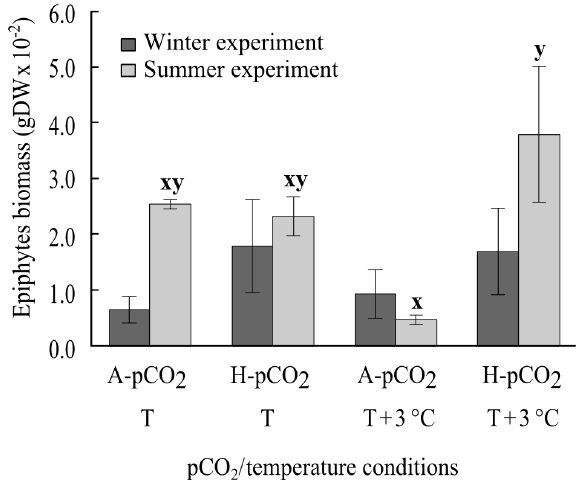
Figure 4. Biomass of epiphytic fleshy algae (mean ± SE, n = 5) ob- tained in the different p CO 2 (A- p CO 2 is ambient p CO 2 ; H- p CO 2 is high- p CO 2 ) and temperature ( T is ambient temperature; T + 3 ◦ C is high temperature) treatments after the 3-month experiments in winter (dark gray) and summer (light gray) experiments. Letters in- dicate significant differences between the four treatments (x, y in the summer; Tukey HSD test). Tukey tests were performed when a significant effect of temperature or p CO 2 was detected using two- way ANOVAs.